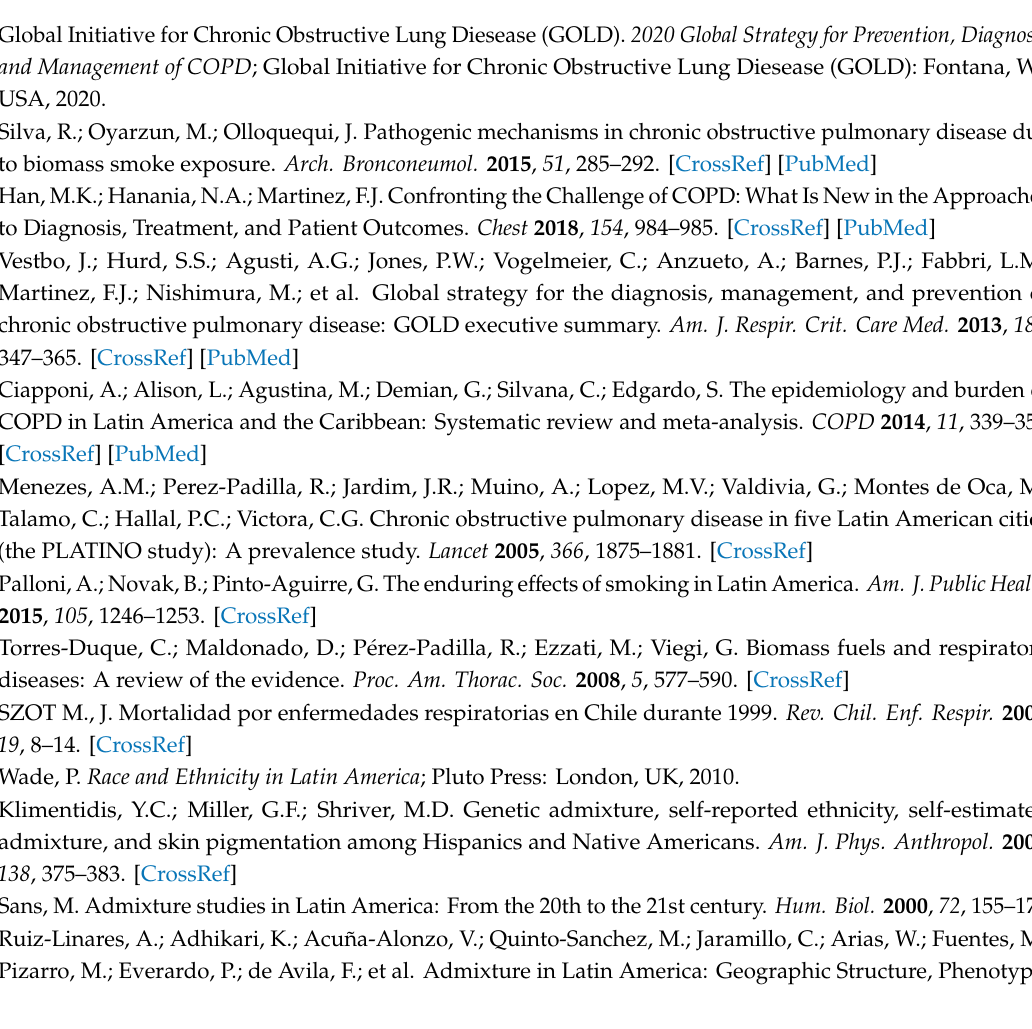
Supplementary Figure S1: Analysis of mortality rate in Chile; Supplementary Table S1: Eighty-nine common single nucleotide polymorphisms (SNPs) included in the study from previous genome wide association studies (GWAS) in populations of diverse ethnic background; Supplementary Figure S2: Single-marker allelic association results; Supplementary Table S2: Single-SNP allelic association analysis ( p < 10 − 5 ); Supplementary Figure S3: Linkage disequilibrium plots around the PRDM15